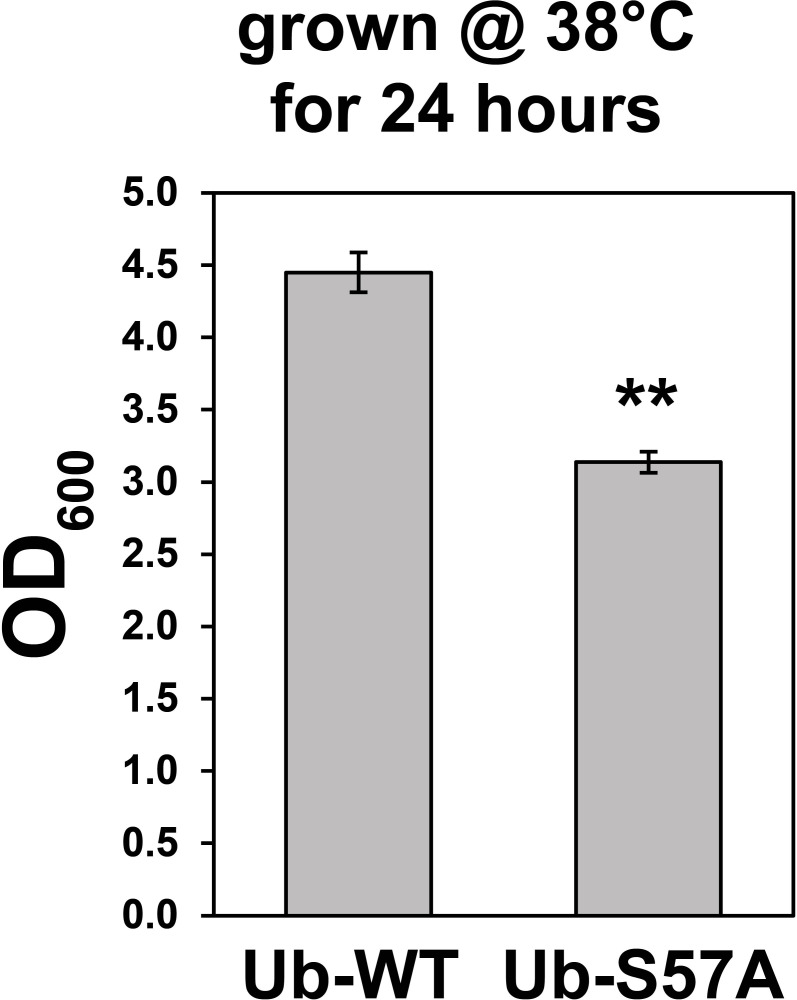
Yeast cells expressing S57A ubiquitin are sensitive to thermal stress.Cells in liquid culture (-URA synthetic medium) were grown at 38°C with a starting OD600 of 0.1 and growth was measured after 24 hr of incubation. Values are means of OD600 from three replicates (n = 3) ± SD (error bars). Double asterisk (**) indicates p value < 0.005 using a Student’s t-test. For all statistical analysis associated with this figure supplement, p values are reported in the Figure 1—source data 1.